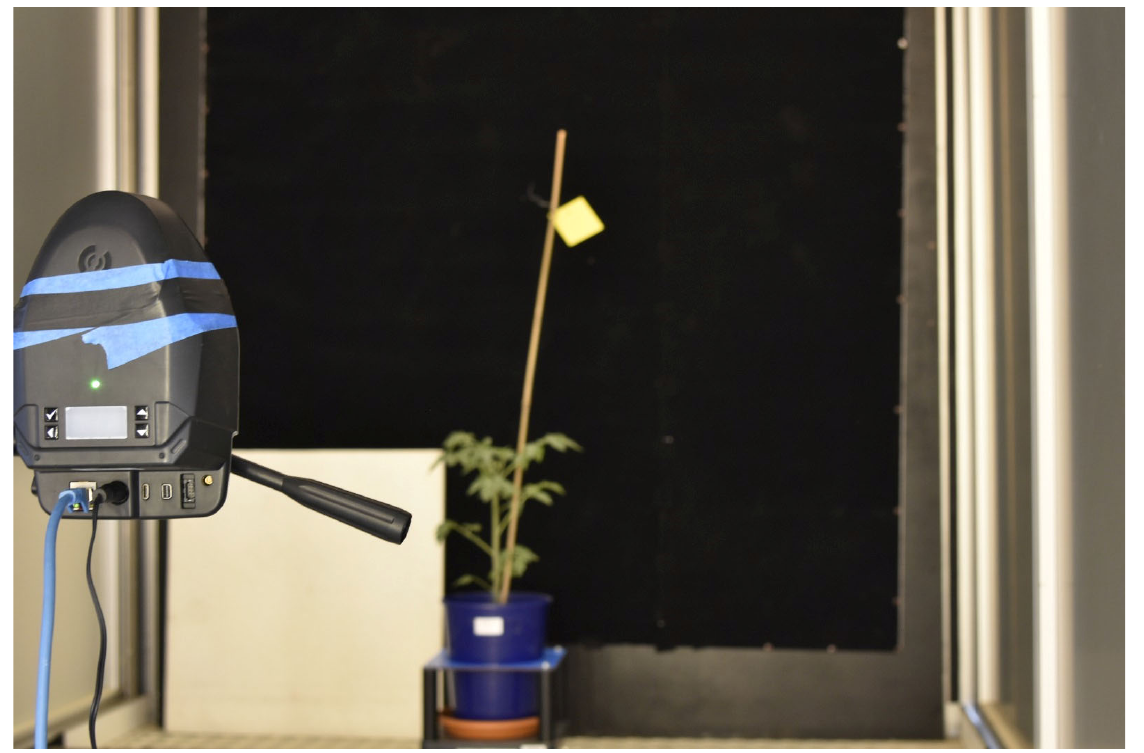
Figure 10. Hyperspectral acquisition process on tomato plant. The white Lambertian surface reference target at 75% of reflectance is the white panel on the plant’s left.